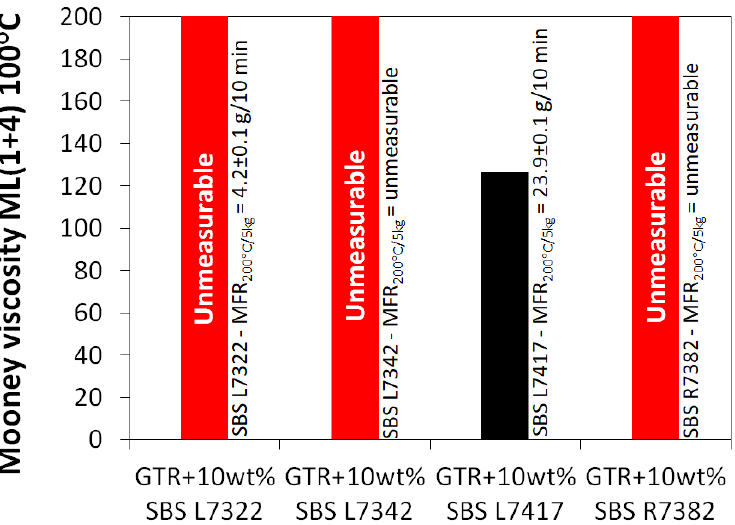
Figure 3. Mooney viscosity of GTR modified by 10 wt% of SBS copolymer as a function of SBS grade.